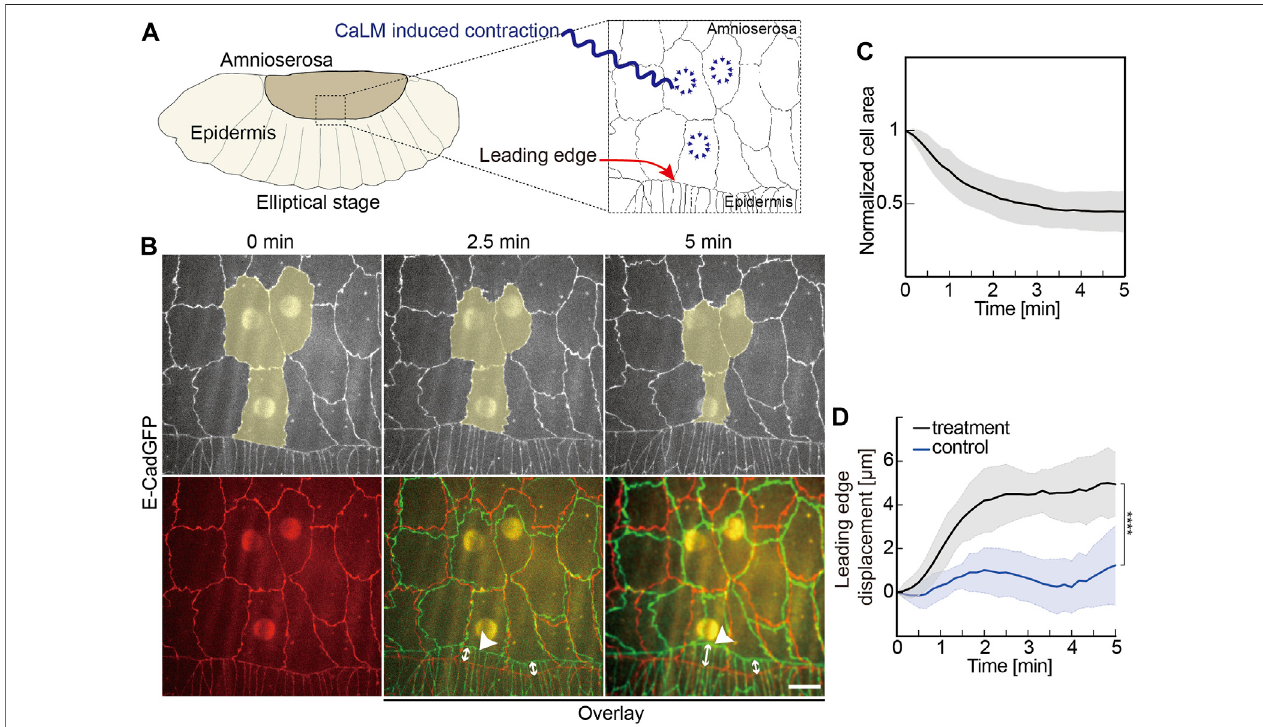
FIGURE2| InducedcontractilityintheASpromotesdorsalclosure. (A) Experimentalschemeofoptochemically(CaLM,Ca 2+ uncagingbyUVillumination)induced contractionofAScells at theellipticalstage in Drosophila embryos. The target cellsofUV illumination areblue, where the cellcontractility istriggered optochemically. (B) Imagesfromatime-lapserecordingofanembryoexpressingE-CadGFPafteroptochemicallyinducedcontractionintargetAScells.Targetcellsarehighlightedinyellow. Image at 0 min is the fi rst frame of a time-lapse recording after UV-laser illumination. The bottom panel shows images ’ overlay at 2.5 and 5 min (green) with the imageat0 min(red). Whitearrow linesindicatetheleading-edgedisplacements. (C) Timecoursesofthecross-sectionalareaofthetargetcellsover5 minafter UV-laser illumination. Cell areas were normalized to their initial size at 0 min. Five independent experiments from fi ve embryos, N = 15 target cells from fi ve embryos, and three target cells from each embryo. (D) Quanti fi cation of the leading-edge displacement dorsally over 5 min after UV-laser illumination. The leading edge far away from the optochemically induced contracting AS cells in the same embryo was used as control. Five independent experiments from fi ve embryos, two-way ANOVA, Sidak ’ s multiple comparison test, **** p < 0.0001. Curves represent the mean (bold line) with SD (ribbon band) in panels (C,D) .